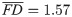
Mean FD map of healthy controls(N = 55).Mean FD map calculated from the voxel-wise mean FD value for healthy controls FD¯=1.57, σ = 0.13. FD = 2-H. Grey matter mask was calculated from a probability atlas [43].